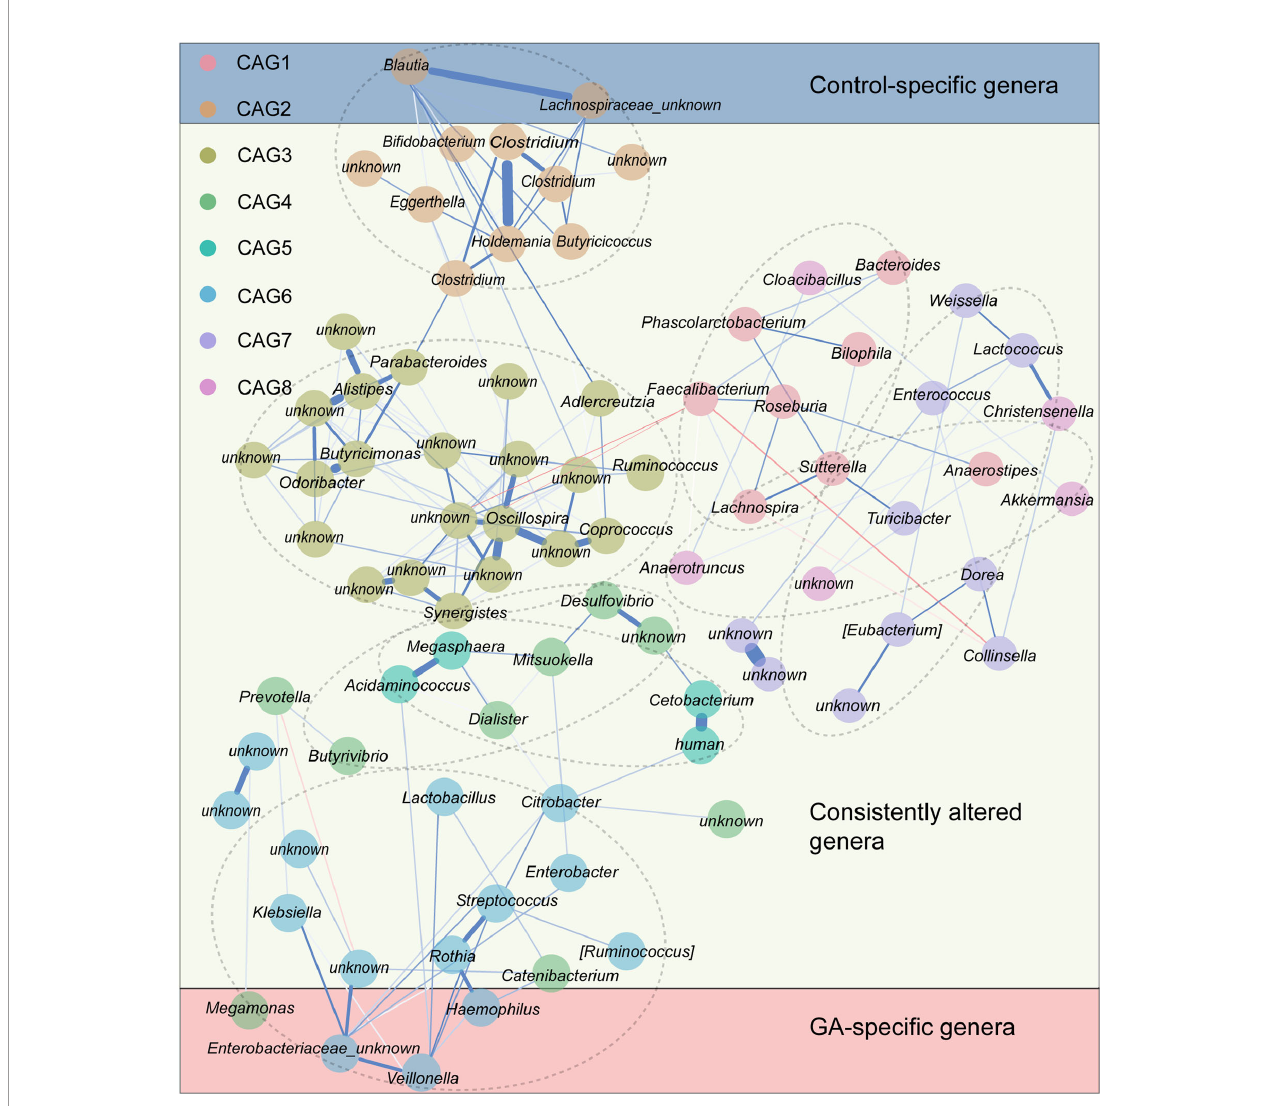
FIGURE 4 | Co-abundance group network re fl ecting microbial changes in GA and healthy control. Regularized partial correlation network of top altered taxa in GA in the second trimester. Each node represented a taxon, and each edge represented the strength of partial correlation between two taxa. Edge weights represented the partial correlation coef fi cients. Blue edge represented positive correlation, and red edge represented negative correlation. GA, gestational